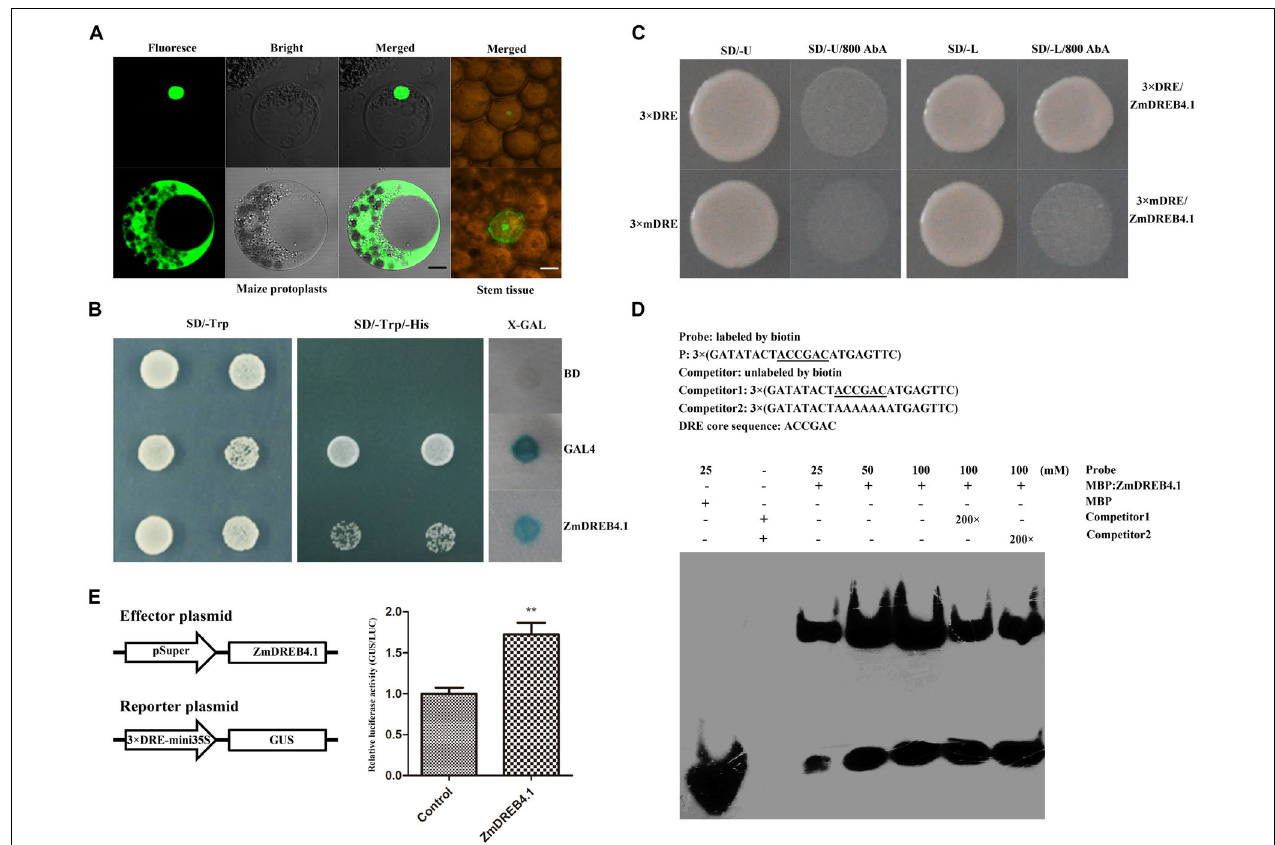
FIGURE 2 | Transcription factor characteristics of ZmDREB4.1. (A) Subcellular localization of the ZmDREB4.1 transcription factor in maize mesophyll protoplasts and young stem tissue. The black and white scale bars indicate 5 and 10 µ m, respectively. (B) Transcriptional activation analysis of ZmDREB4.1 in the yeast. GAL4 and BD indicate the positive control and negative control, respectively. (C) Yeast one-hybrid assay. ZmDREB4.1 binds to the DRE element, but not the mDRE element. (D) EMSA. The DRE core sequence is marked by underlines. ZmDREB4.1 specifically binds to the DRE element. (E) Transcriptional activation analysis of ZmDREB4.1 in tobacco leaves. GUS/LUC value indicated ZmDREB4.1 activates the expression of GUS gene driven by the fusion promoter of 3 × DRE and mini 35S. The leaves co-transformed with the empty p1300Super effector, the GUS reporter, p19 and p35S::LUC severed as the control. The GUS/LUC value of the control was set to 1. The values represent the mean ± SD from three biological replicates and the statistically significant differences were evaluated by Student’s t -test ( ∗∗ P -value <